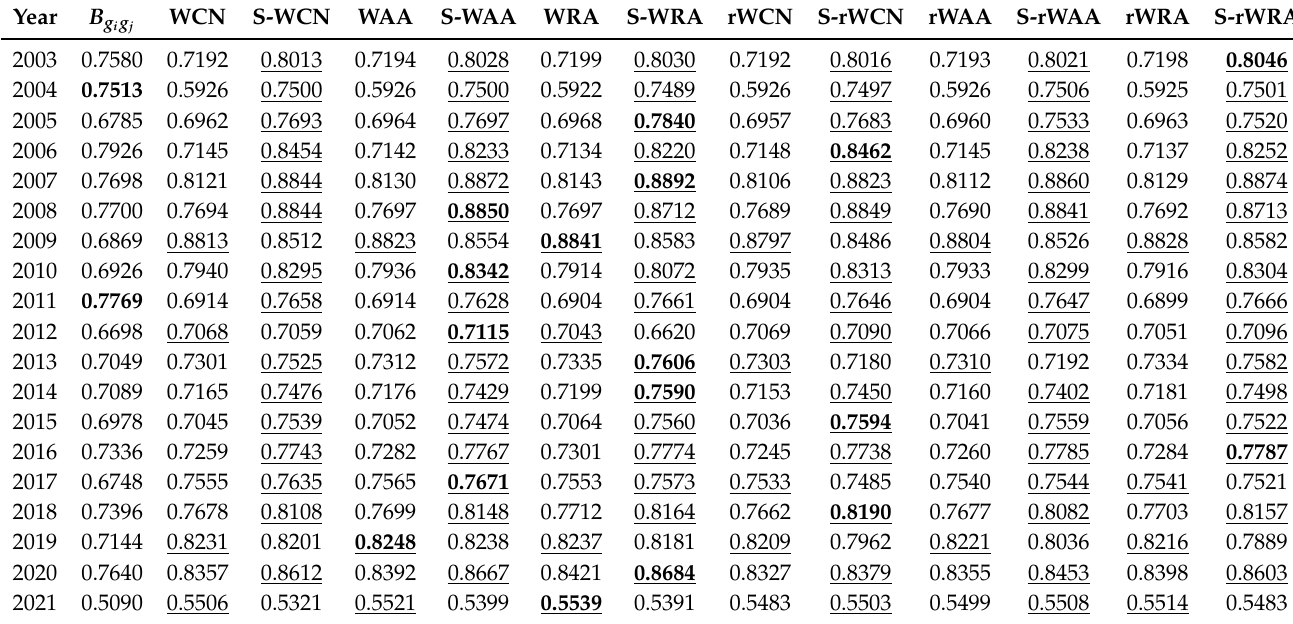
Table 2. Performance evaluation of the synergistic link-prediction methods based on AUC. Six synergy-based indices were implemented in this study, namely, S-WCN, S-WAA, S-WRA, S-rWCN, S-rWAA, and S-rWRA, which aim at enhancing the corresponding local similarity measures (i.e., WCN, WAA, WRA, rWCN, rWAA, and rWRA) by incorporating the community-based index B g Pairwise comparisons were conducted between the synergy-based index and its corresponding local similarity measure. The one with the better performance is underlined. The best link predictor for each year is marked in bold. It is observed that the synergy-based indices outperformed both B g and the corresponding local similarity measures in most cases, which could validate the existence and usefulness of the synergistic effect between two scales on link